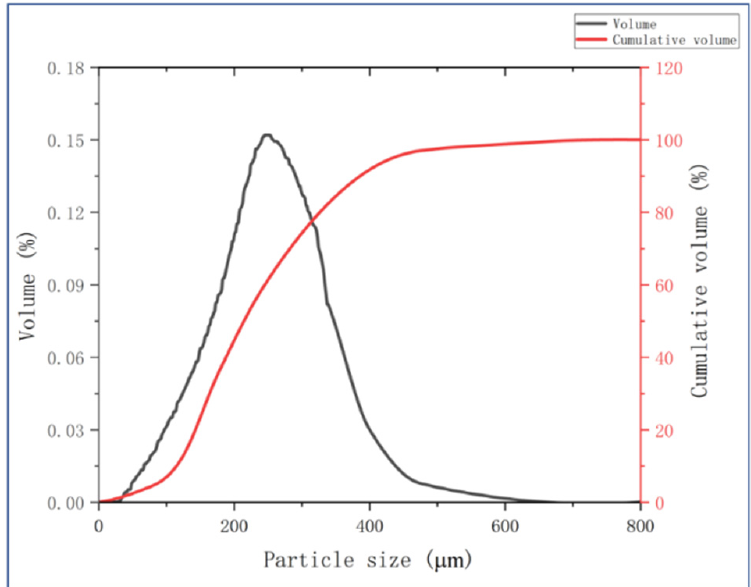
Figure 4. The particle size distribution of PUF powder.